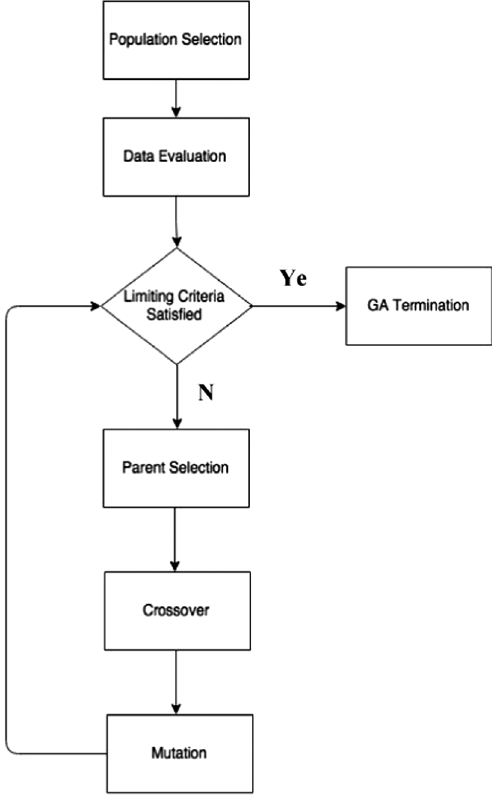
FIG. 22. Genetic algorithm approach.